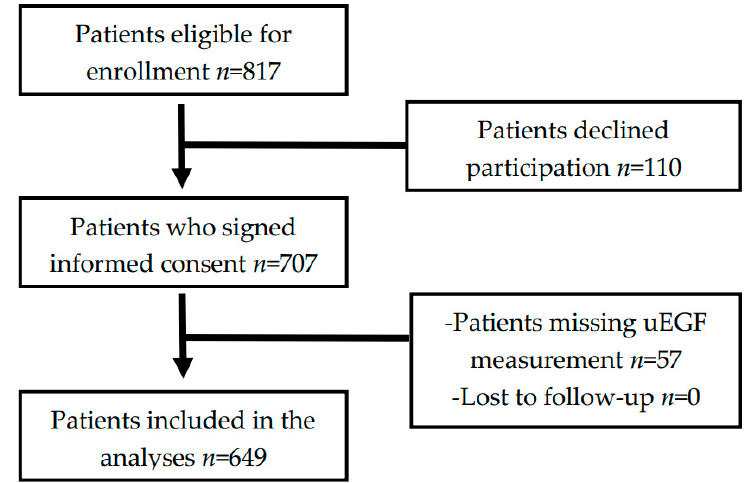
Figure 1. Participant flow